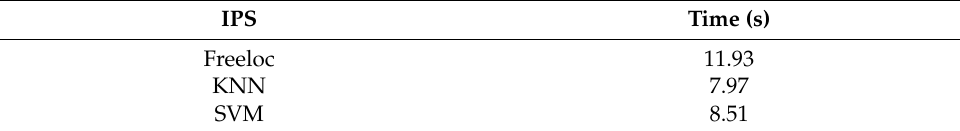
Table 7. Processing time for the Freeloc, KNN, and SVM for a validation route.